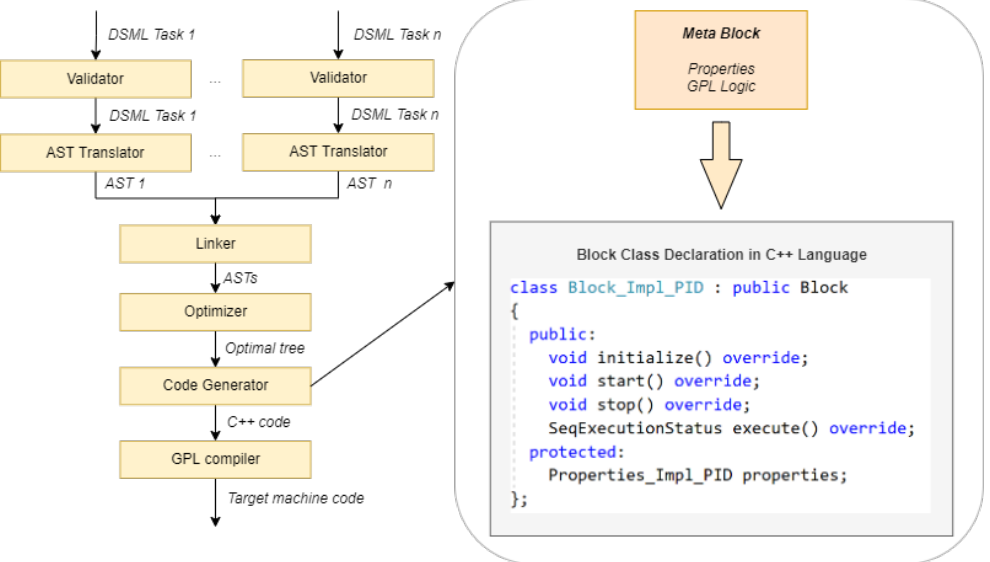
Figure 7. Model to code in